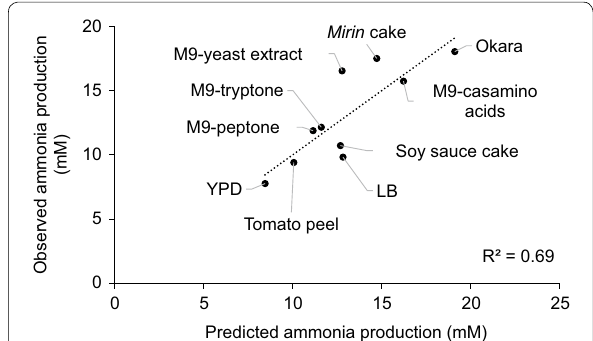
Fig. 2 Relationship between actual and predicted ammonia production using the PLS model. The concentration of ammonia produced by E. coli DH10B from four food by-products and six media containig amino acids was plotted against the concentration of ammonia predicted by PLS regression. The data of ammonia concentration are expressed as the mean values (n predicted ammonia production was calculated by PLS regression